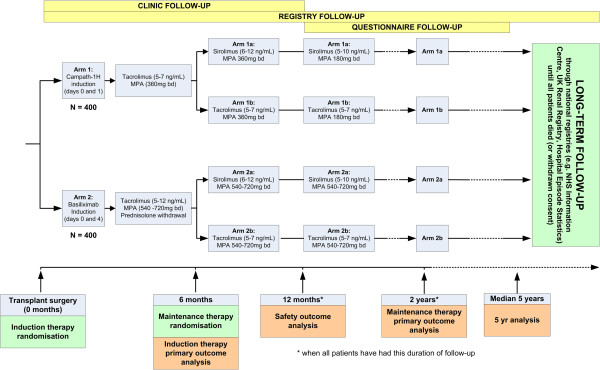
Flowchart showing study treatments and randomizations, including proposed analyses.